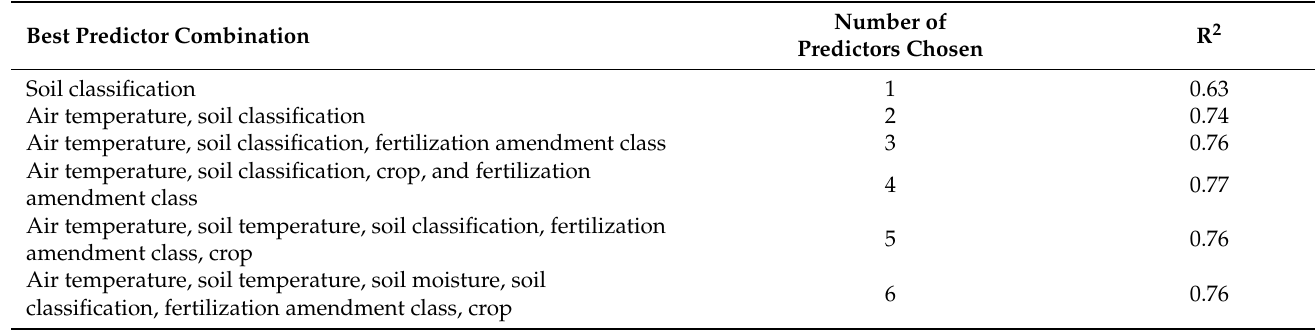
Table 3. Forward feature selection on the training